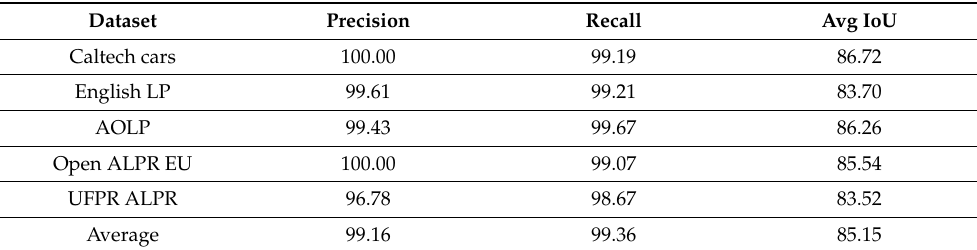
Table 7. LP detection results (%) in all five